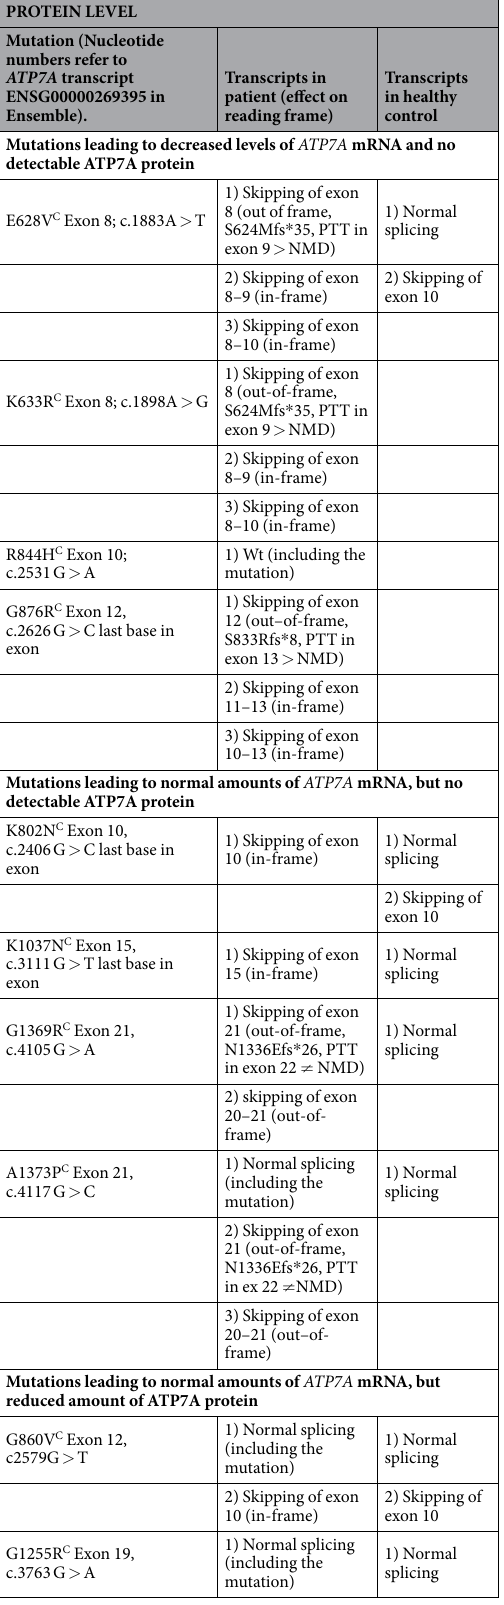
Table 1. Sequence of PCR products obtained by spanning RT-PCR. “A” denote atypical, “O” OHS, and “C” classical